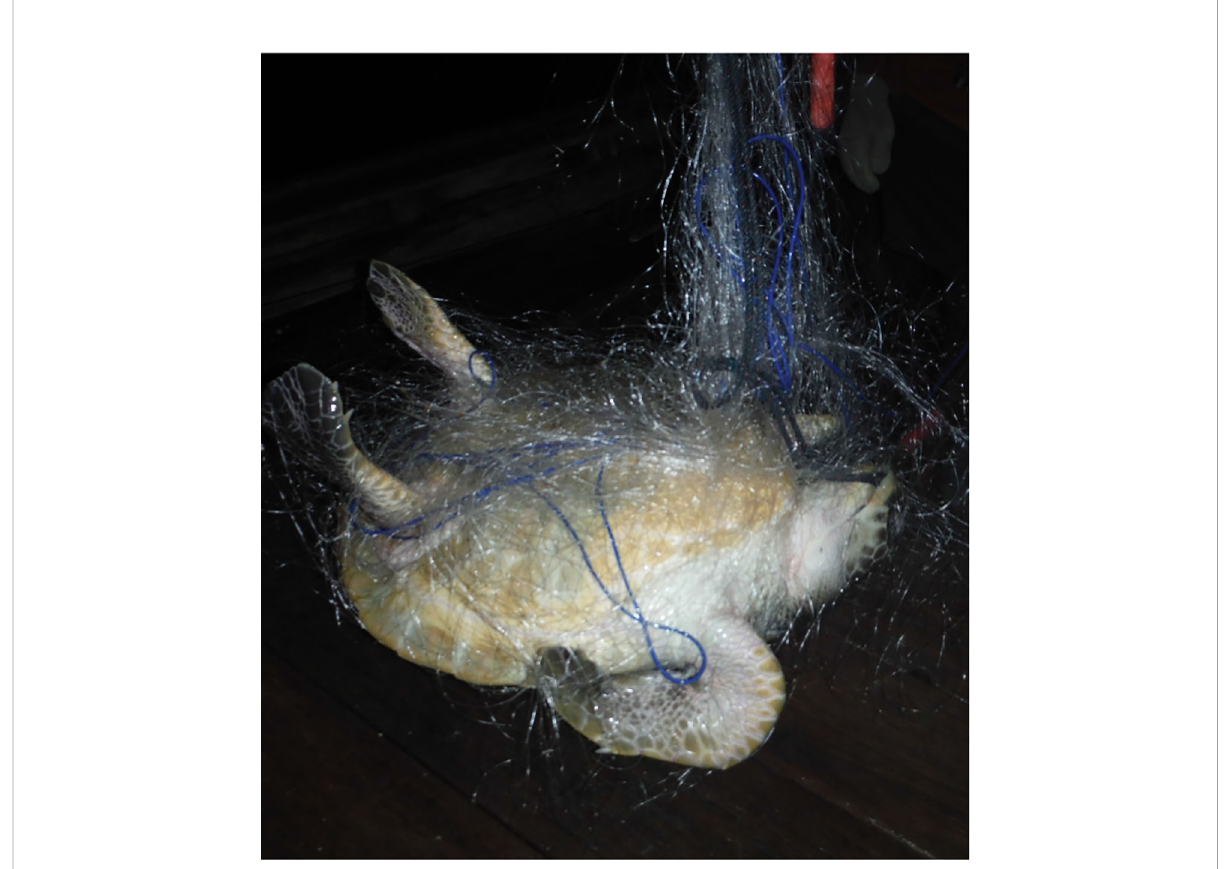
FIGURE 3 Sea turtle bycatch often results in extensive tangling of the nets which reduces the fi shing ef fi cacy of large portions of the net. Removing sea turtles from these tangles require substantial effort and time from fi shers and can result in signi fi cant damage to the fi shing